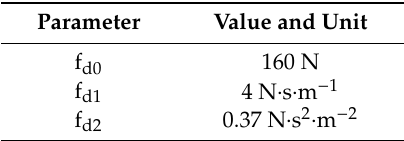
Table A3. Coe ffi cients of driving